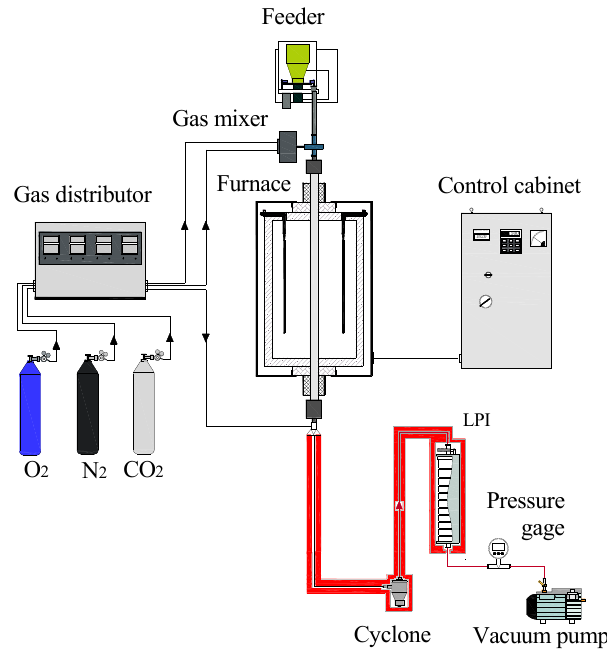
Figure 2. Schematic diagram of high-temperature drop-tube furnace (HDTF).